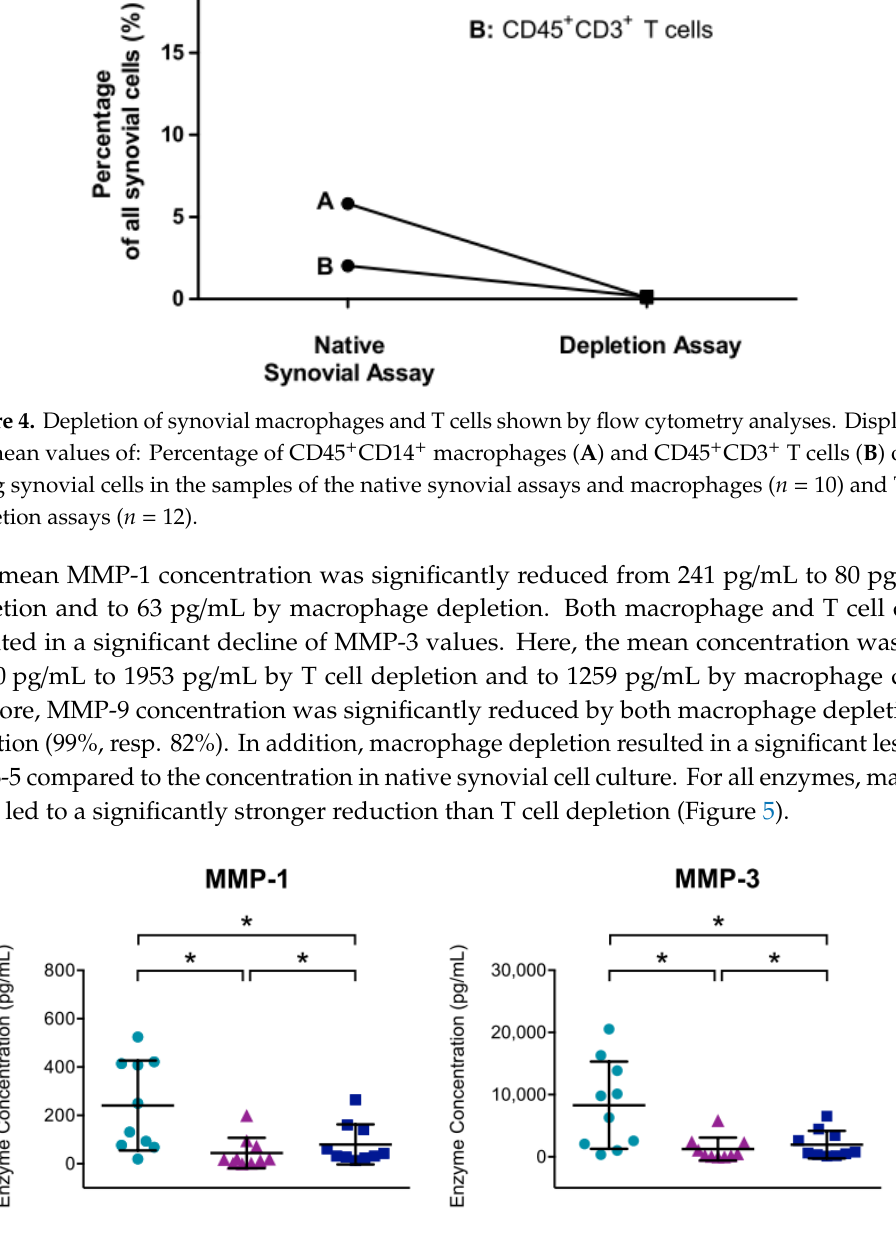
Figure 5. Effect of mononuclear cell depletion on MMP and ADAMTS production of synovial cell cultures is shown. After enzymatic digestion of synovial membrane from patients with advanced knee OA, depletion of CD14 + macrophages and CD3 + T cells was performed using magnetic activated cell sorting. Cells of native synovial assays and depletion assays were cultured for 12 h at 37 °C and 5% CO 2 . Enzyme linked immunosorbent assays were then used to analyze enzyme production in culture supernatants. Mean and standard deviation of enzyme concentrations of MMP-1/-3/-9 and ADAMTS- 5 are plotted ( n = 7). Significant differences are indicated by asterisks: * p < 0.05. In addition, production of MMP-13, ADAMTS-5 and ADAMTS-7 were analyzed, but concentrations were below detection level. 3.4. Impact of CD4 + CD127 dim/- Enriched PBMC on Catabolic Activity of Chondrocytes and the Effect of Treg In order to investigate the interaction between mononuclear cells and chondrocytes, a series of co-culture experiments were set up and the enzyme release was assessed (Figure 6). Compared to chondrocyte monoculture, a significant increase of more than six-fold was detected for MMP-1 in chondrocyte co-culture with CD4 + CD127 dim/- -enriched PBMC. The mean ADAMTS-5 concentration, which was 498 pg/mL in the chondrocyte monoculture, was also significantly increased to 1279 pg/mL in the chondrocyte co-culture with CD4 + CD127 dim/- -enriched PBMC. The enzyme concentrations between the chondrocyte monoculture and the two chondrocyte co-cultures with Treg and Treg-depleted, CD4 + CD25 - CD127 dim/- -enriched PBMC showed no significant differences. However, all enzymes were detected in the Treg co-culture at lower concentrations compared to the other co-cultures, which was significant for ADAMTS-5. Furthermore, no significant differences in enzyme concentrations were shown between co-culture with CD4 + CD127 dim/- -enriched PBMC (including Treg) and co-culture with Treg-depleted, CD4 + CD25 - CD127 dim/- enriched-PBMC.